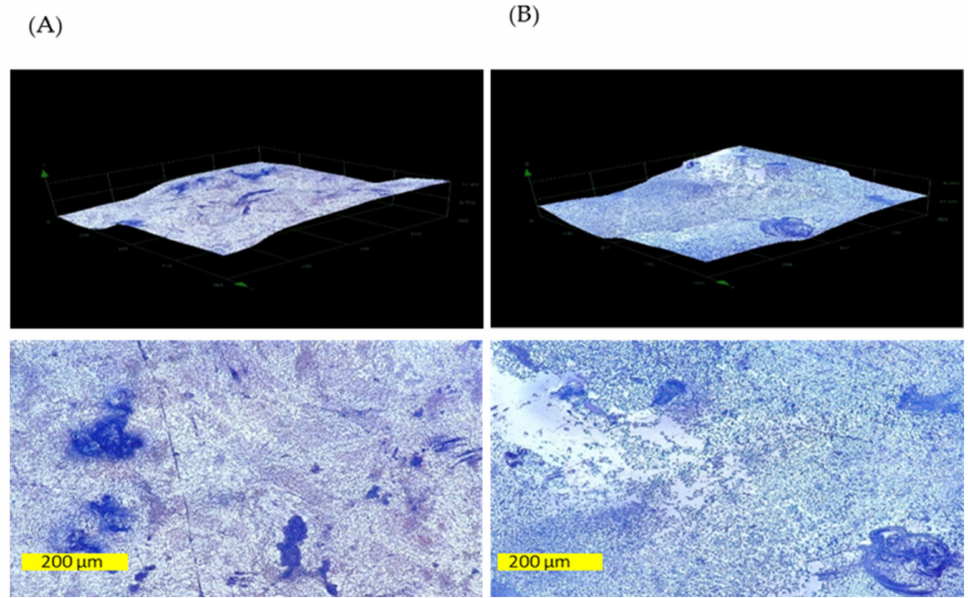
Figure 6. The three-dimensional ( above ) and two-dimensional ( below ) images of ceramic tiles surfaces inoculated with representative strain K. pneumoniae NCTC 13442 biofilm: control sample ( A ) and ozone-treated sample ( B ). The dark blue stains present the bacteria stained with crystal violet. Changes in biofilm topology after the ozone treatment with 25 ppm/1 h were ob- served with AFM (D, E, F), resulting in cell aggregation with empty areas without bacteria (Figure 7). Moreover, variations in the distribution chart that follows the distribution of peaks in the three-dimensional biofilm structure suggests that after the ozone treatment, the biofilm height is reduced from 725.4 nm to 158.5 nm and from 355.4 nm to 173.0 nm (E–F), respectively.